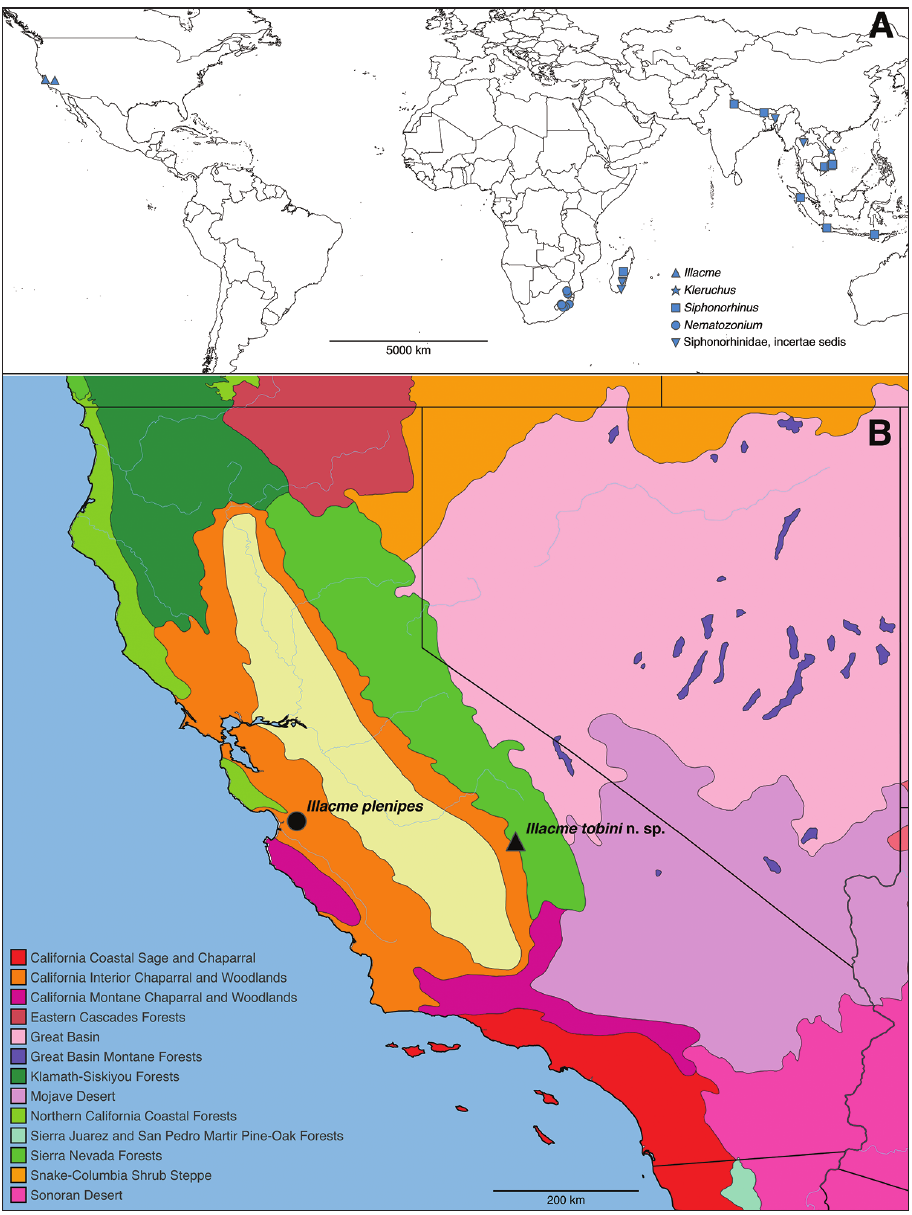
Figure 1. A Distribution of the millipede family Siphonorhinidae, and B of the genus Illacme . Terrestrial ecoregions according Olson et al.